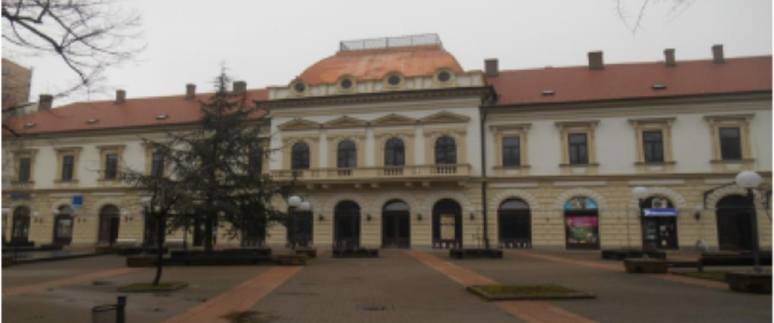
Figure 9. The Diocese in Pan č evo, Serbia—a view of the front façade.